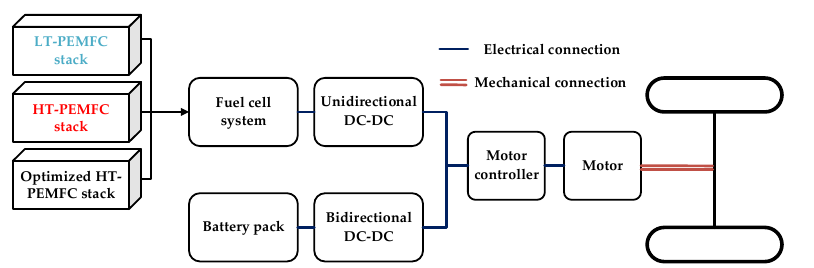
Figure 7. Different PEMFC schemes of the FC + B powertrain.